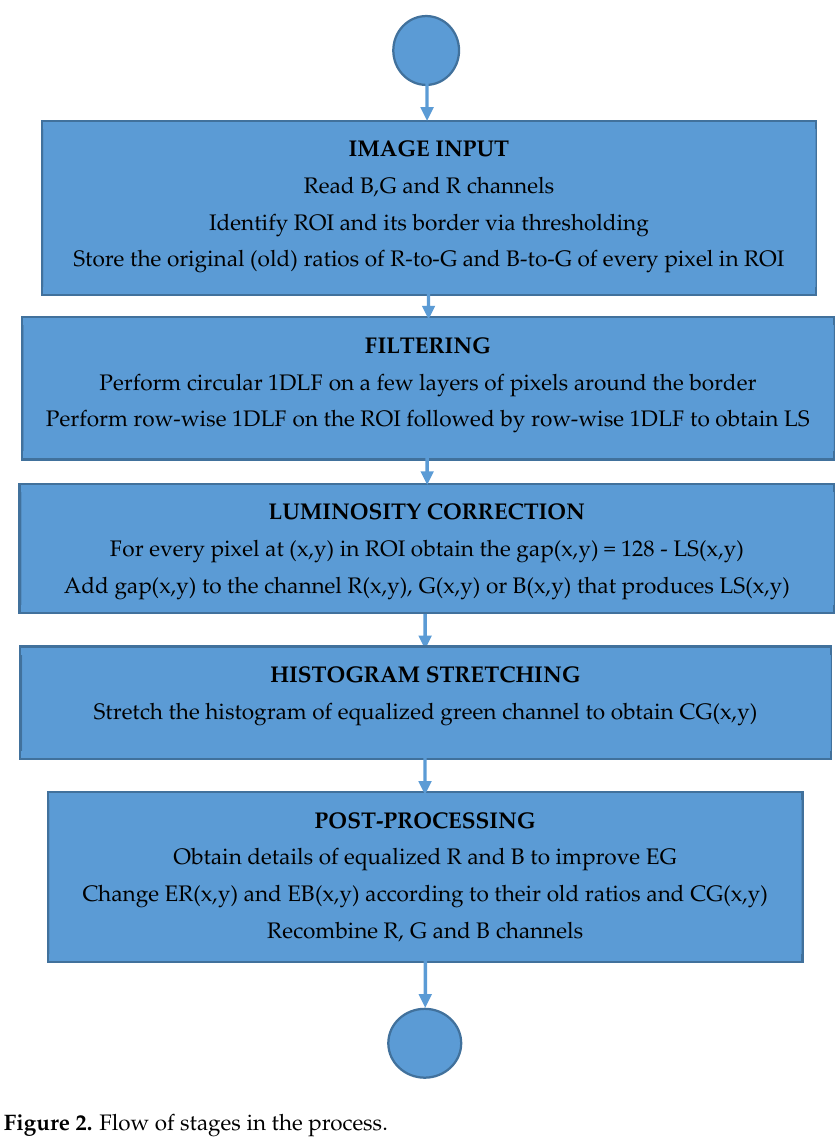
Figure 2. Flow of stages in the process.